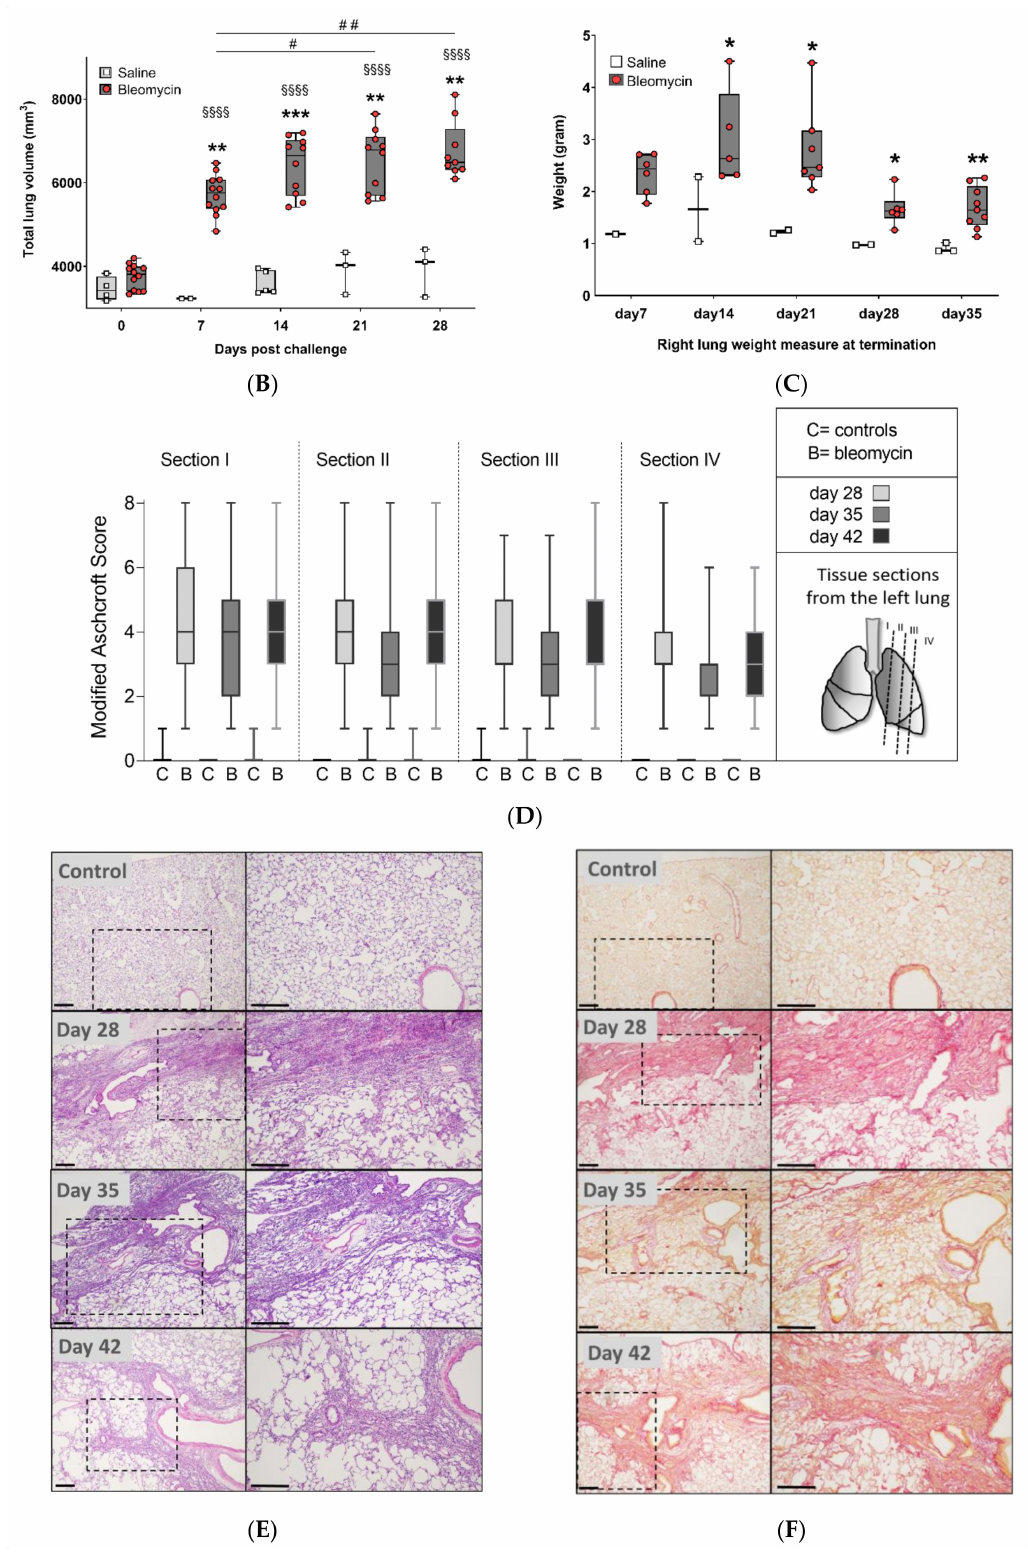
Figure 2. Model characterization and measures of basic parameters. ( A ) Bodyweight changes over time, ( B ) Total lung volume over time, assessed by MRI, and ( C ) right lung lobe weigh at termination (from Group II). ( D ) Fibrosis scoring evaluated by the modified Ashcroft score at day 28, 35, and 42 post-bleomycin challenge. Representative images of lung tissue sections stained by ( E ) H&E and ( F ) Sirius